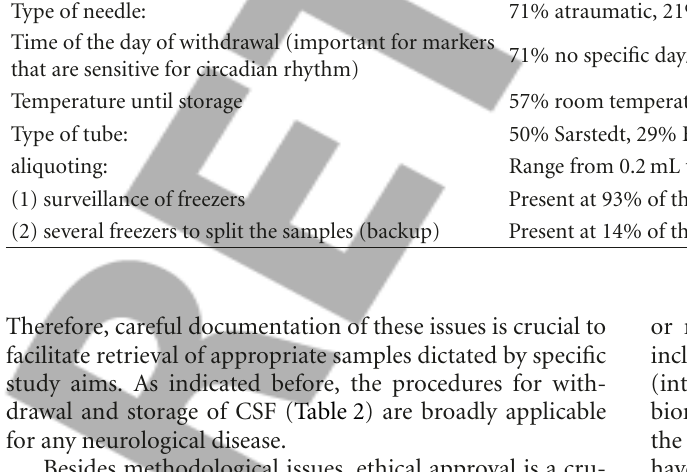
Table 1: Results of inventory on collection protocols among 14 MS Biomarker Research Centers. Procedure of CSF